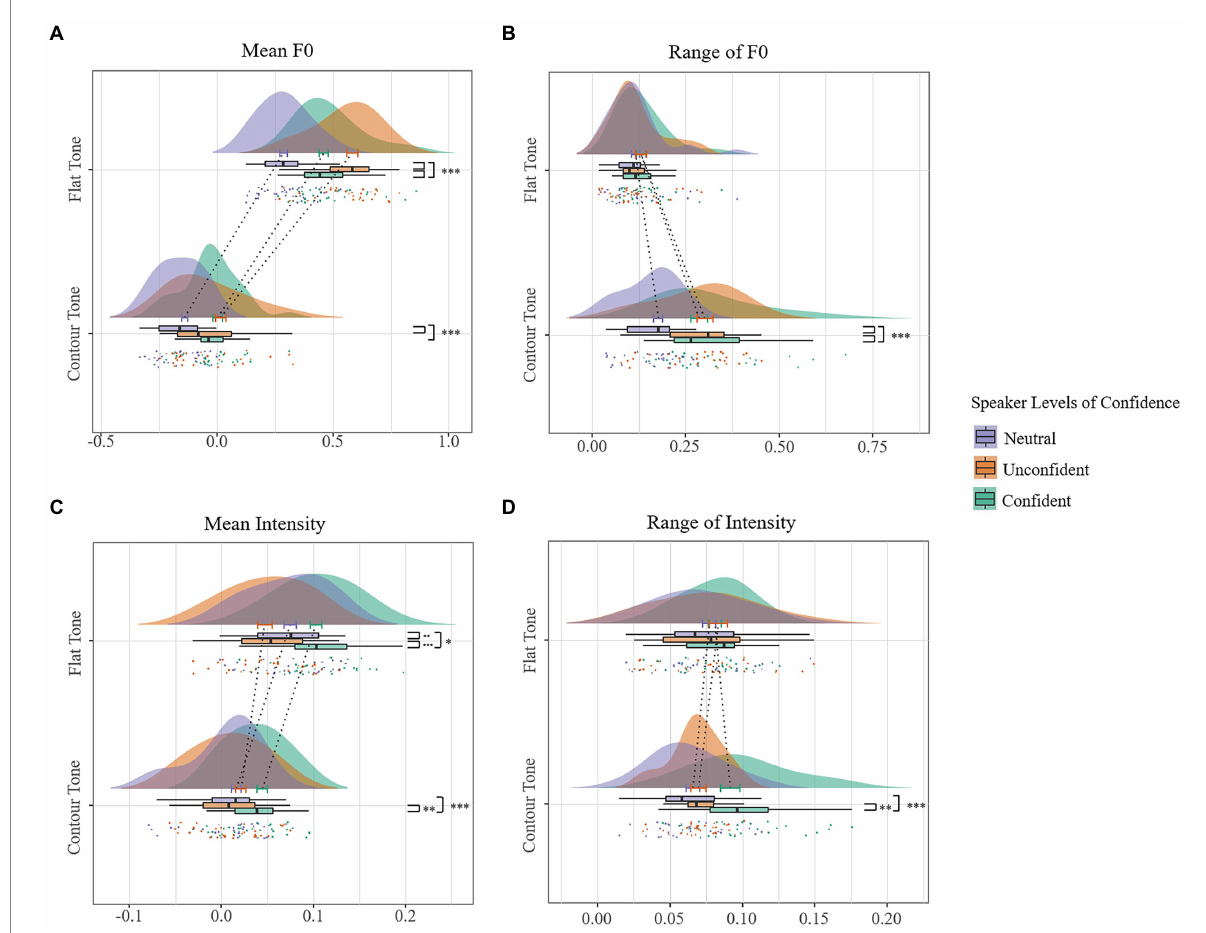
FIGURE 4 Raincloud plots for prosodic features showing the interaction of speaker confidence and lexical tone. (A) mean f0, (B) f0 range, (C) mean intensity, and (D) intensity range per lexical tone per confidence level for all